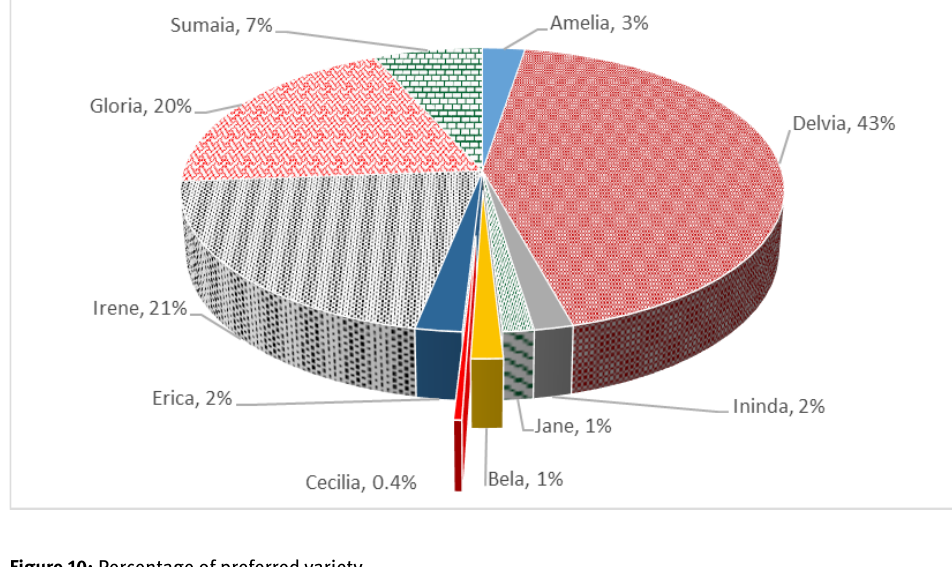
Figure 10: Percentage of preferred variety